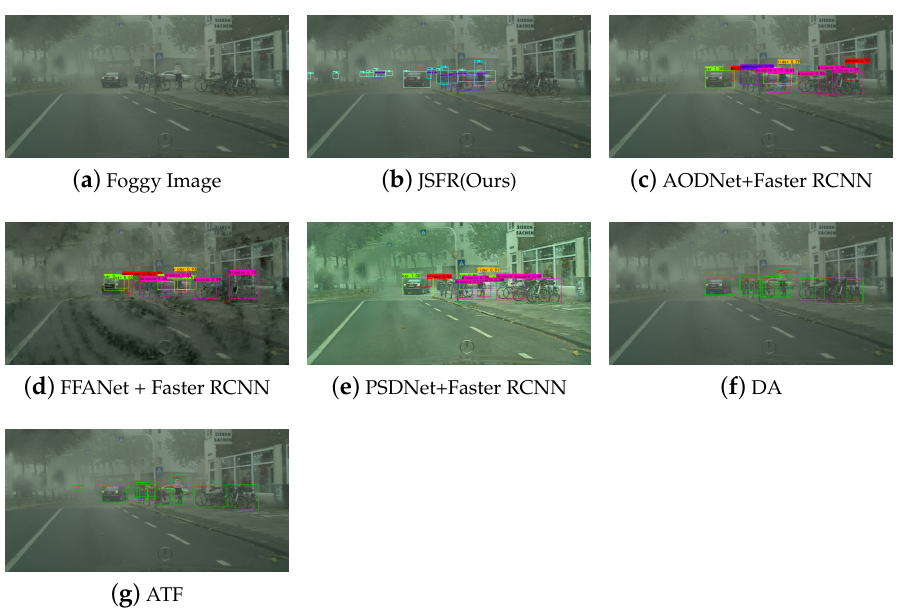
Figure 9. Results comparison of Foggy Cityscapes with dense fog between JSFU , combination methods including AODNet+Faster RCNN , FFANet + Faster RCNN , PSDNet + Faster RCNN , and domain adaptive methods including DA and ATF (electronic zoom-in